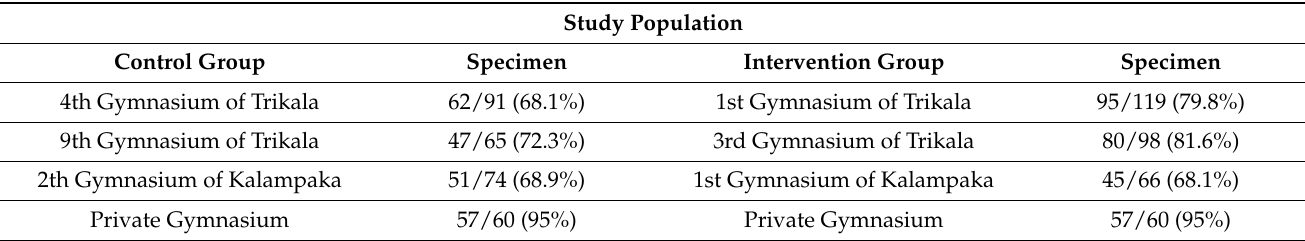
Table 1. Phase I: Response rate of all participants (intervention and control groups) to the question- naires per